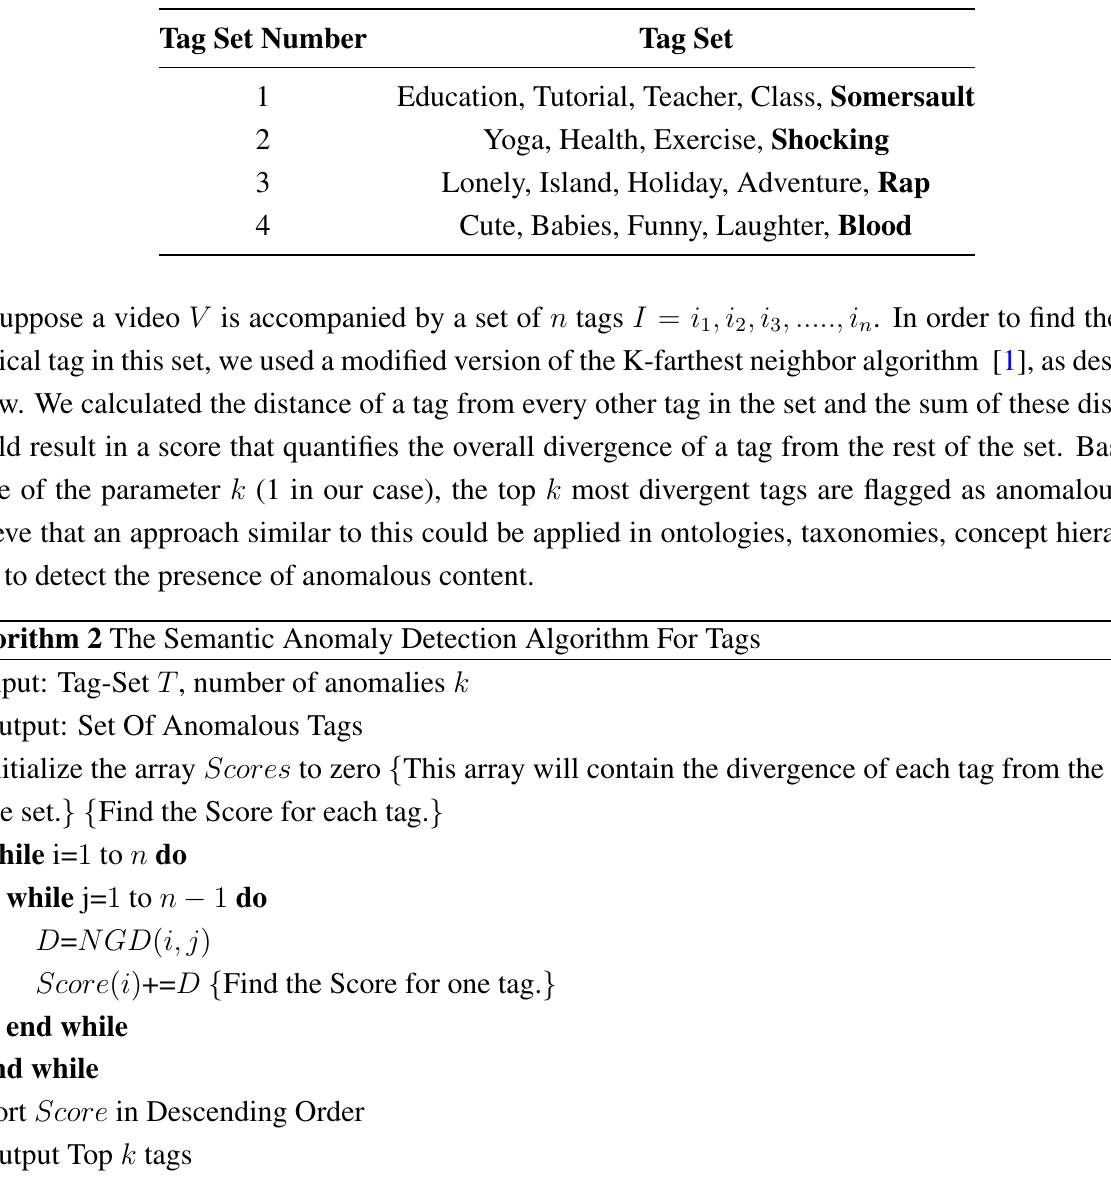
Table 1. Example of Tag-Sets (Visually determined anomalous tag In Bold).